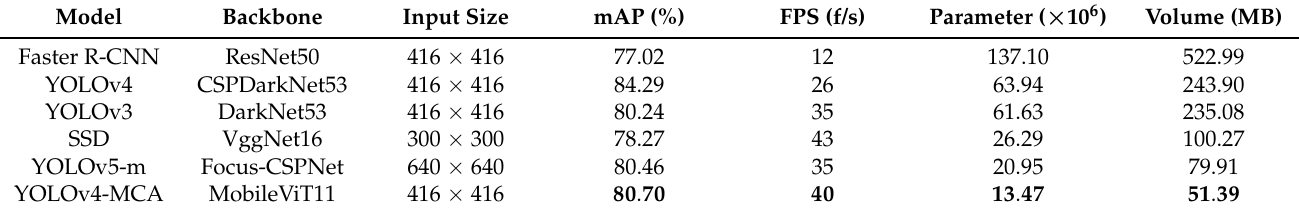
Table 4. The performance comparison of algorithms on PASCAL VOC 07+12.